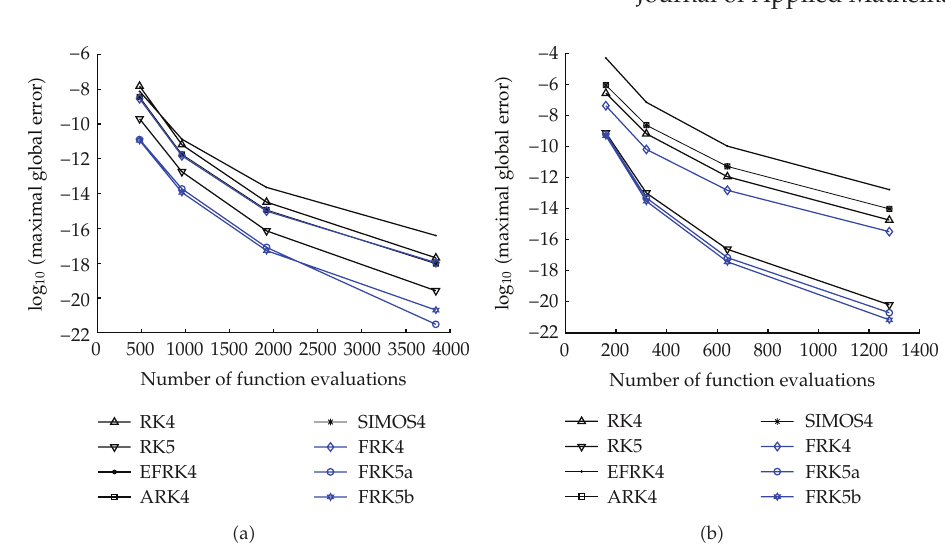
Figure 4: E ffi ciency curves of Problem 3 (cid:3) a (cid:4) and Problem 4 (cid:3) b (cid:4)